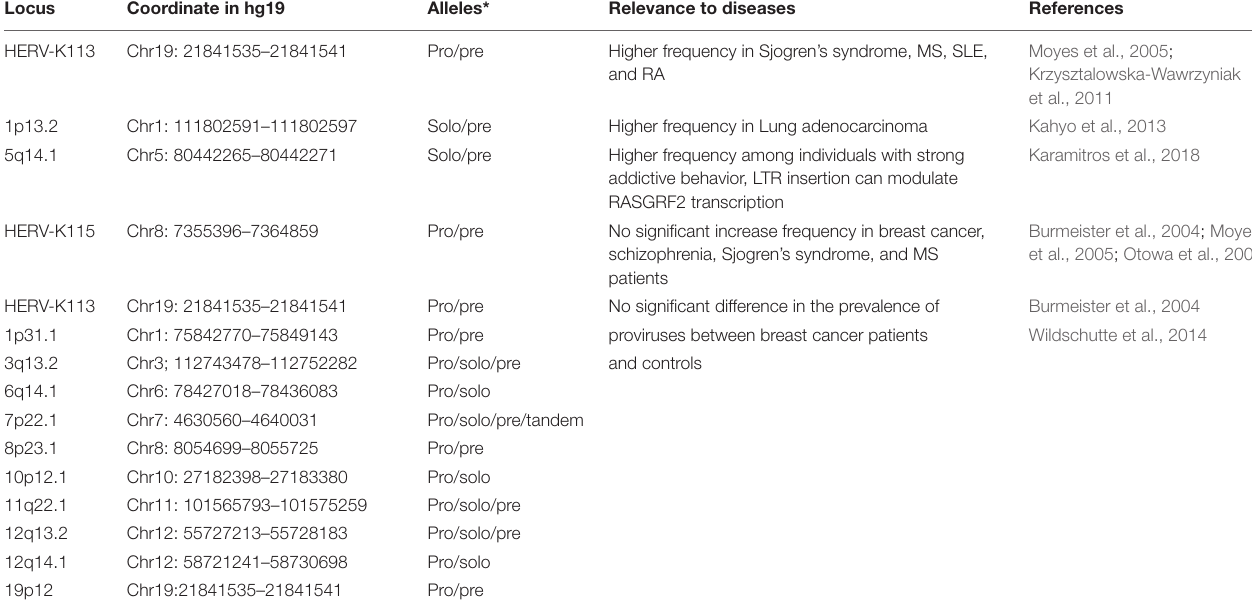
TABLE 1 | Polymorphic integrated HERV-K (HML-2) and diseases.